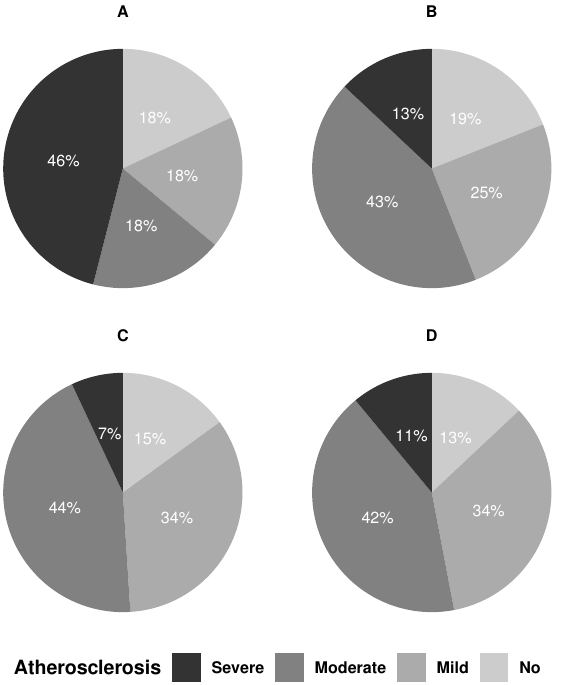
Figure 2. Distribution of internal carotid artery atherosclerosis across TOAST groups. CE: cardioem- Figure2. DistributionofinternalcarotidarteryatherosclerosisacrossTOASTgroups. CE:cardioem- bolism;LAA:largearteryatherosclerosis;SVO:smallvesselocclusion;UD:undeterminedetiology. bolism; LAA: large artery atherosclerosis; SVO: small vessel occlusion; UD: undetermined etiology.